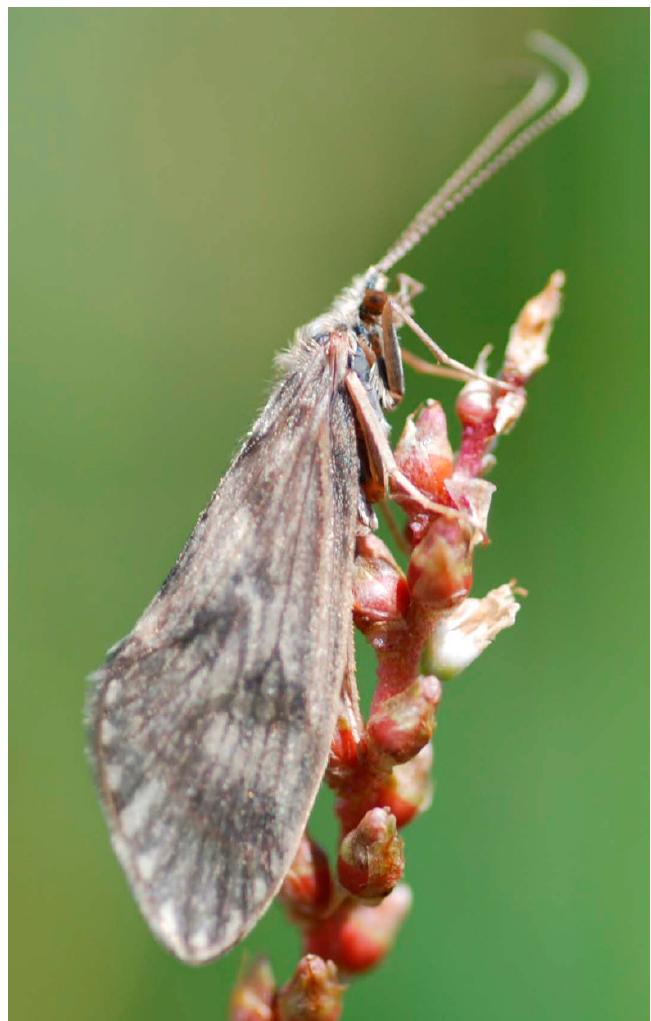
Figure 1. Adult of Brachycentrus americanus (Banks, 1899) (Brachycentridae). © J.C. Morse.